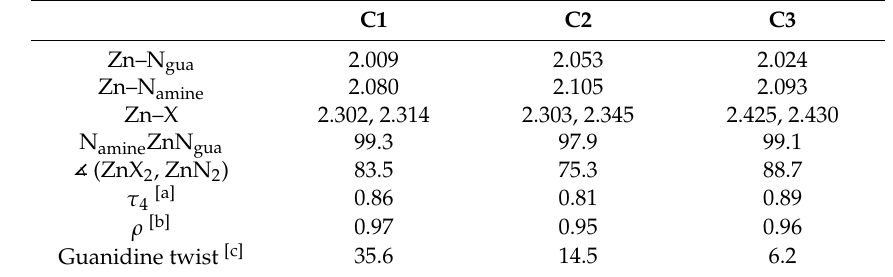
Table 2. Calculated bond lengths [Å] and angles [ ◦ ] of C1 – C3 [Gaussian09, TPSSh, def2-TZVP, GD3BJ,